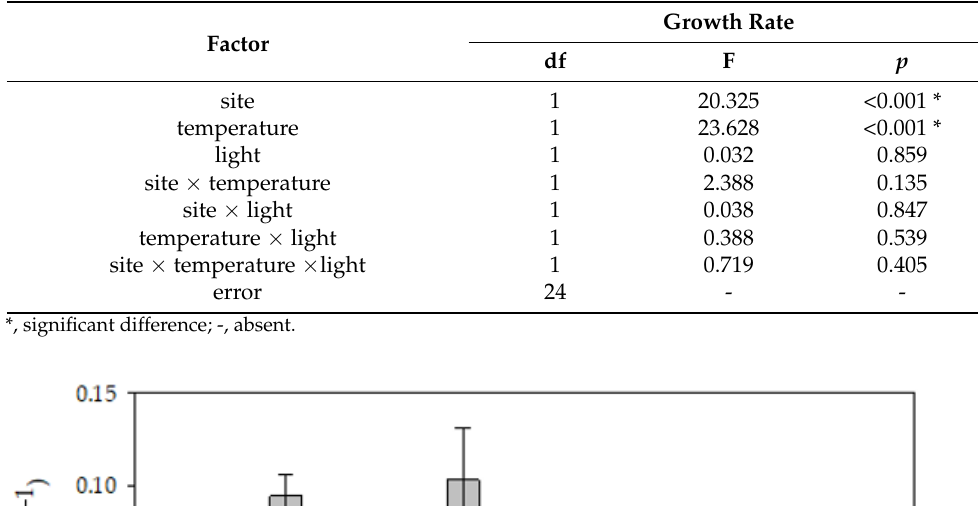
Table 3. Statistical indices of growth rate (three-way ANOVA).